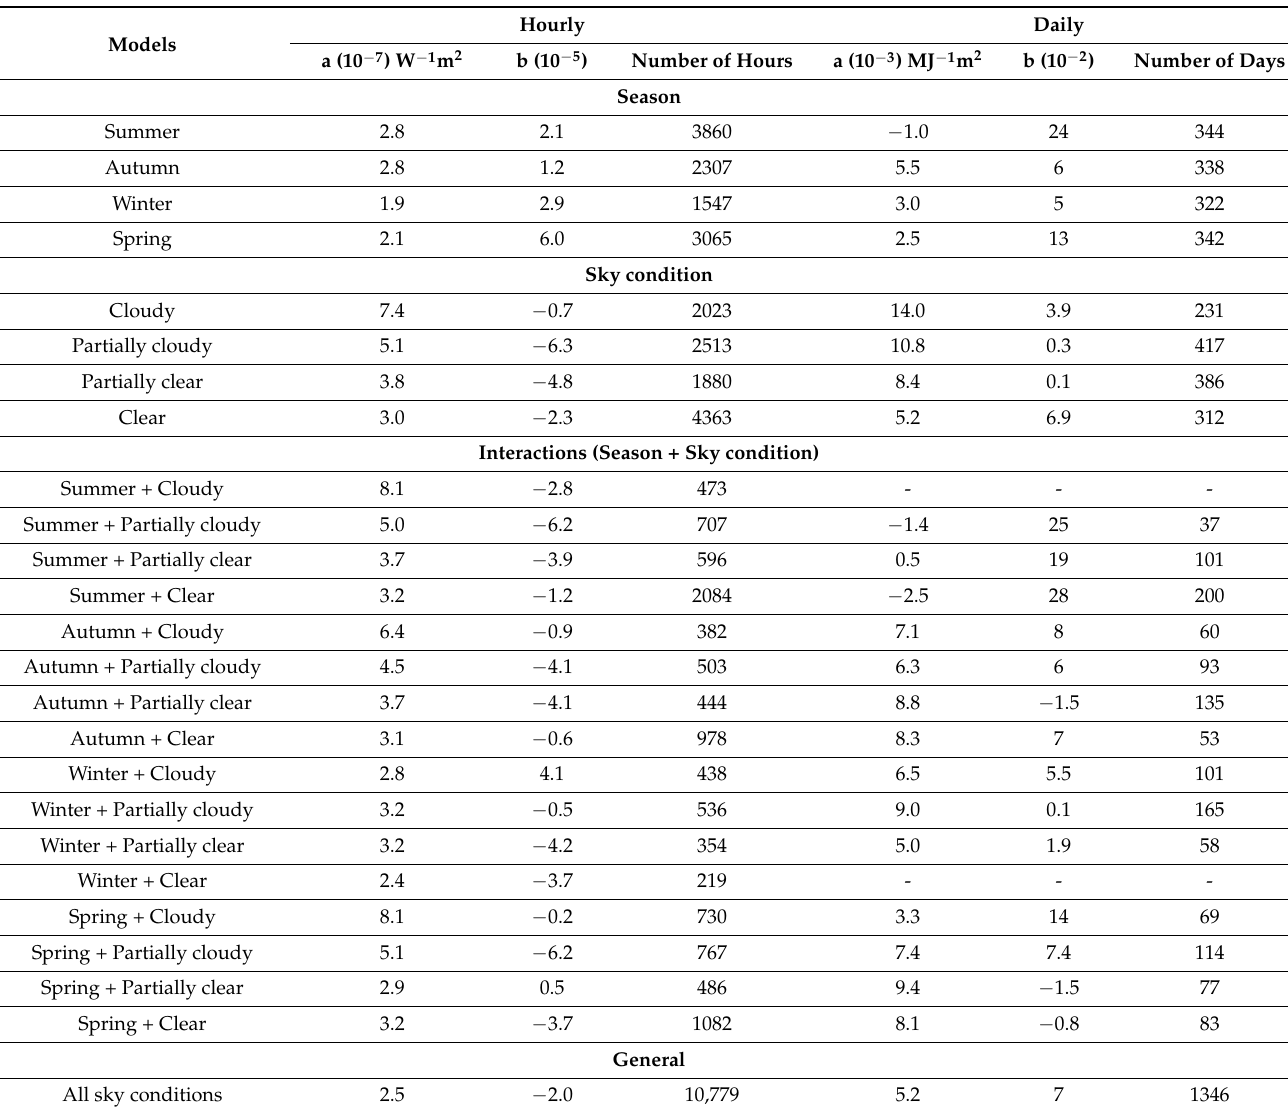
Table 3. Model coefficients (a, b) for hourly and daily values of UVER for Santiago considering observations carried out from 2015 to